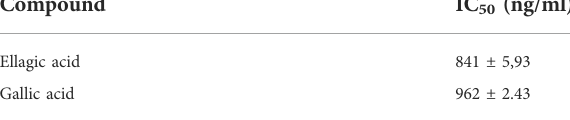
TABLE 6 IC 50 values of ellagic acid and gallic